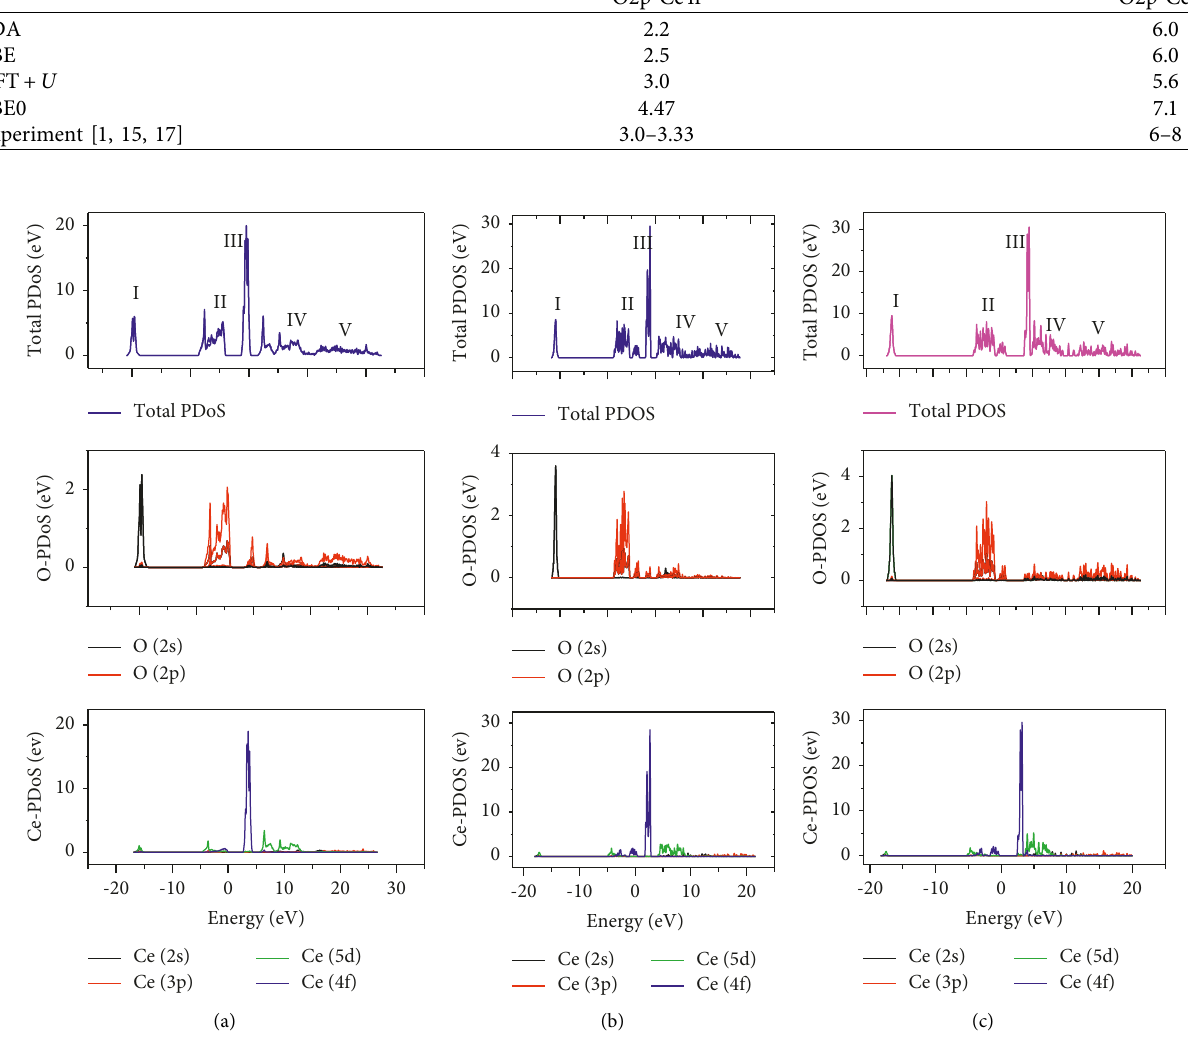
Figure 6: Partial density of states calculated with (a) LDA, (b) PBE, and (c) DFT + U .